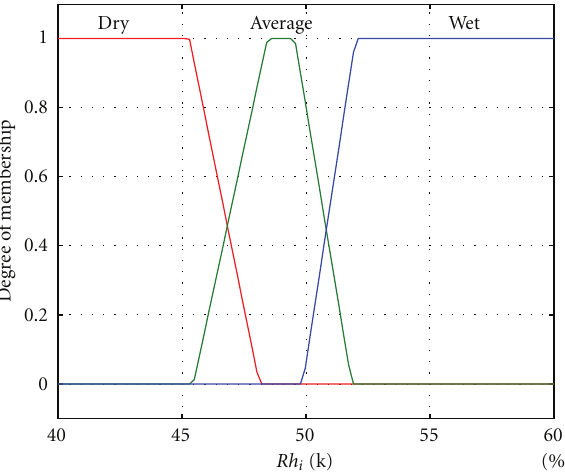
Figure 7: Membership function of the inside